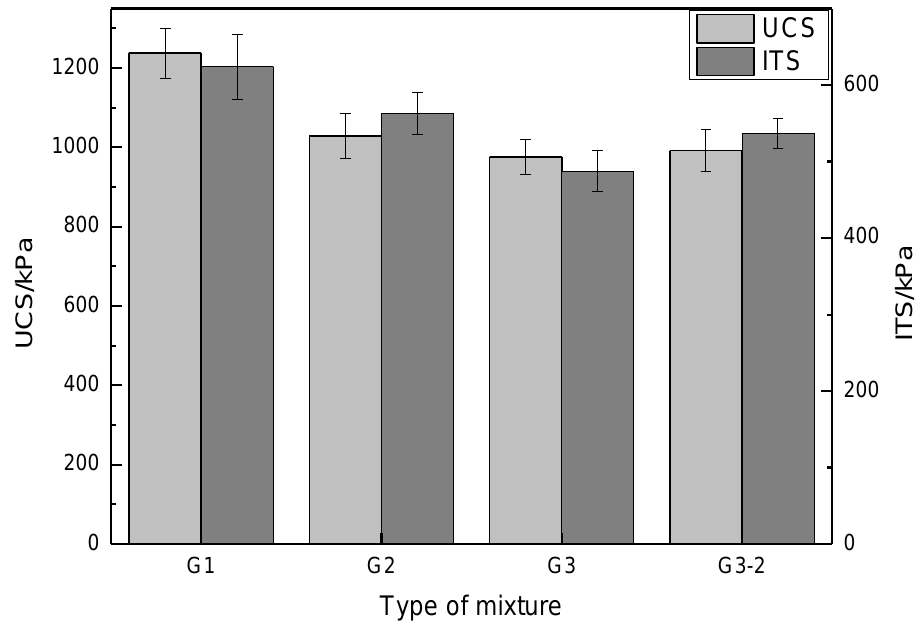
Figure 4. UCS and ITS results for the mixtures with different fine aggregate